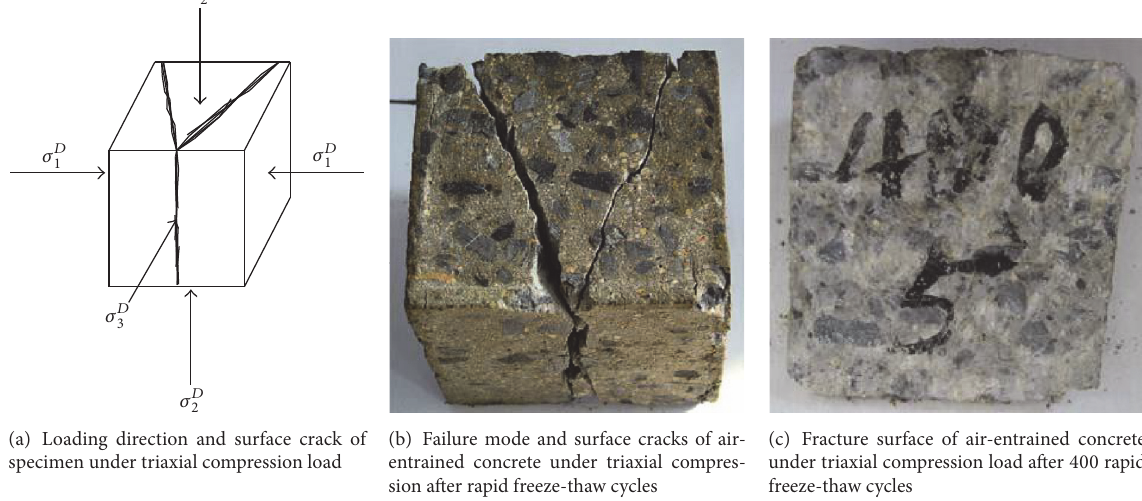
Figure 1: The failure mode and fracture surface of air-entrained concrete specimen after different freeze-thaw